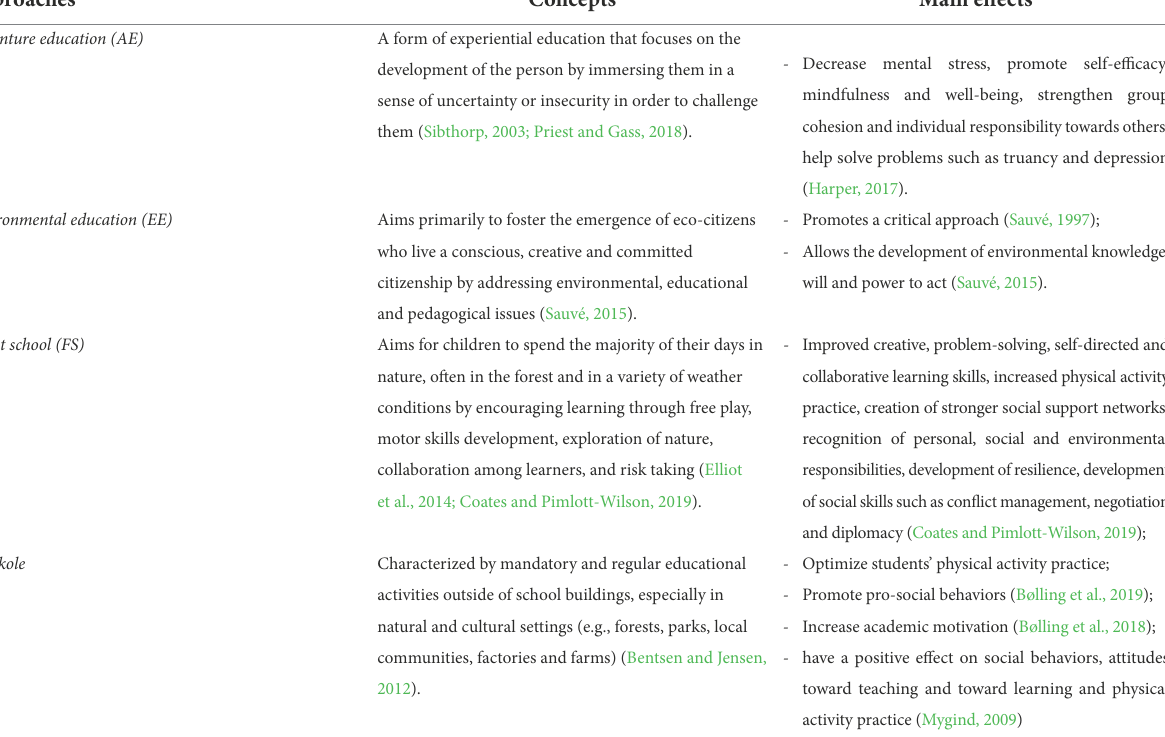
TABLE 1 Synthesis of outdoor education